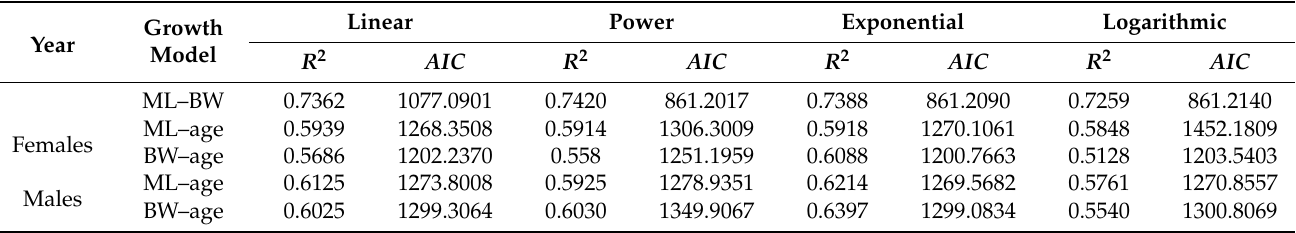
Table 1. Parameters of the linear, power, exponential, and logarithmic growth models fitted to